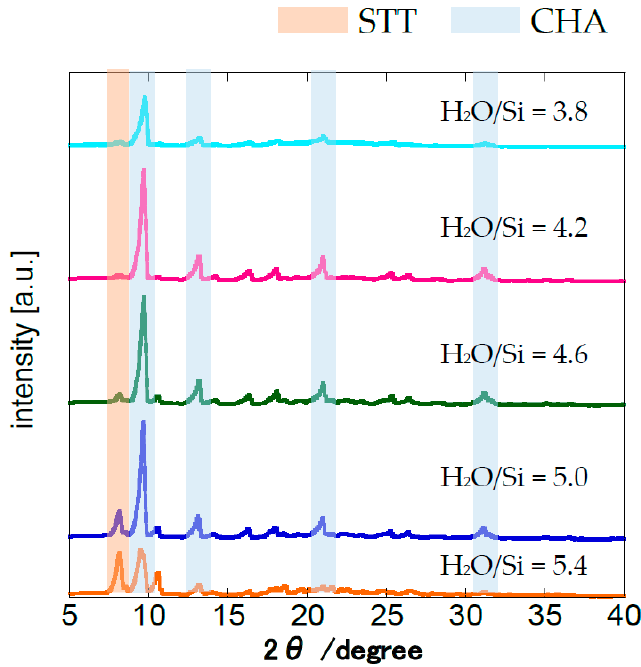
Figure 3. XRD measurements for the membranes crystallized with different H 2 O/SiO 2 ratios. (1 SiO 2 :0.8 TMAdaOH:0.8 HF:X H 2 O, 0.01 wt% CHA seeds, 16 h at 423 K). (1 SiO 2 :0.8 TMAdaOH:0.8 HF:X H 2 O, 0.01 wt% CHA seeds, 16 h at 423